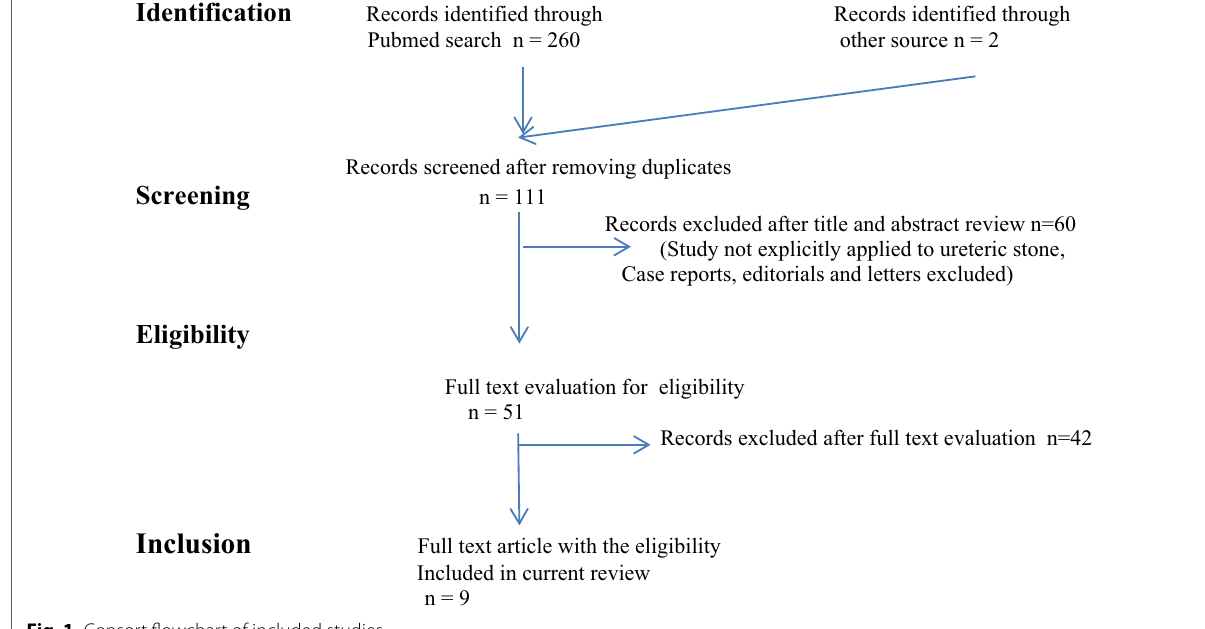
Fig. 1 Consort flowchart of included